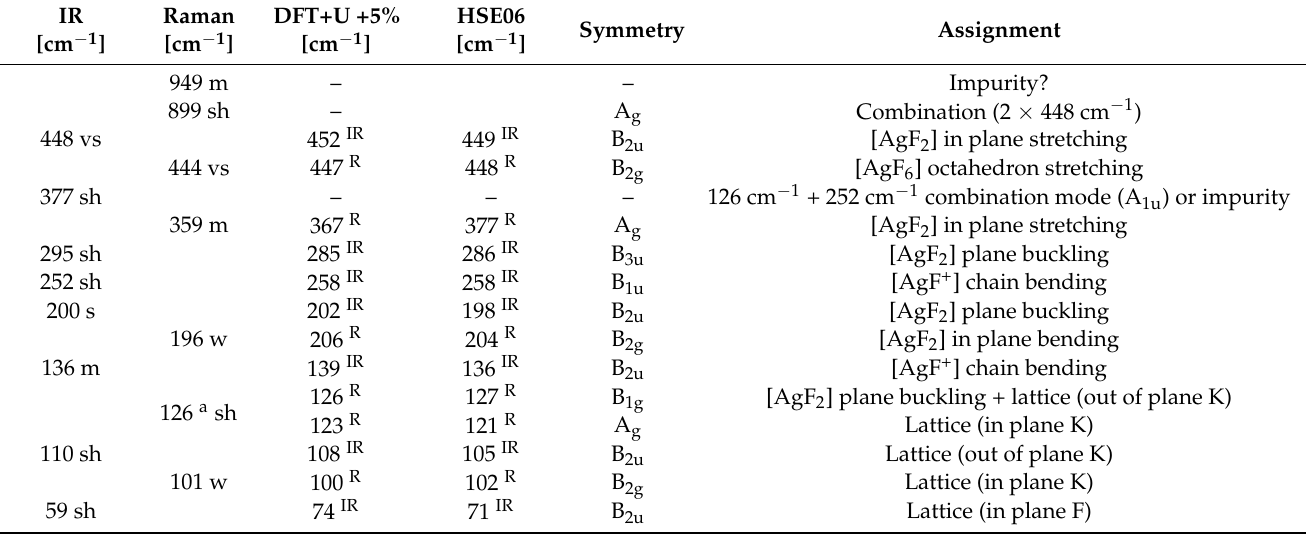
Table 1. Vibrational band assignment for KAgF 3 .